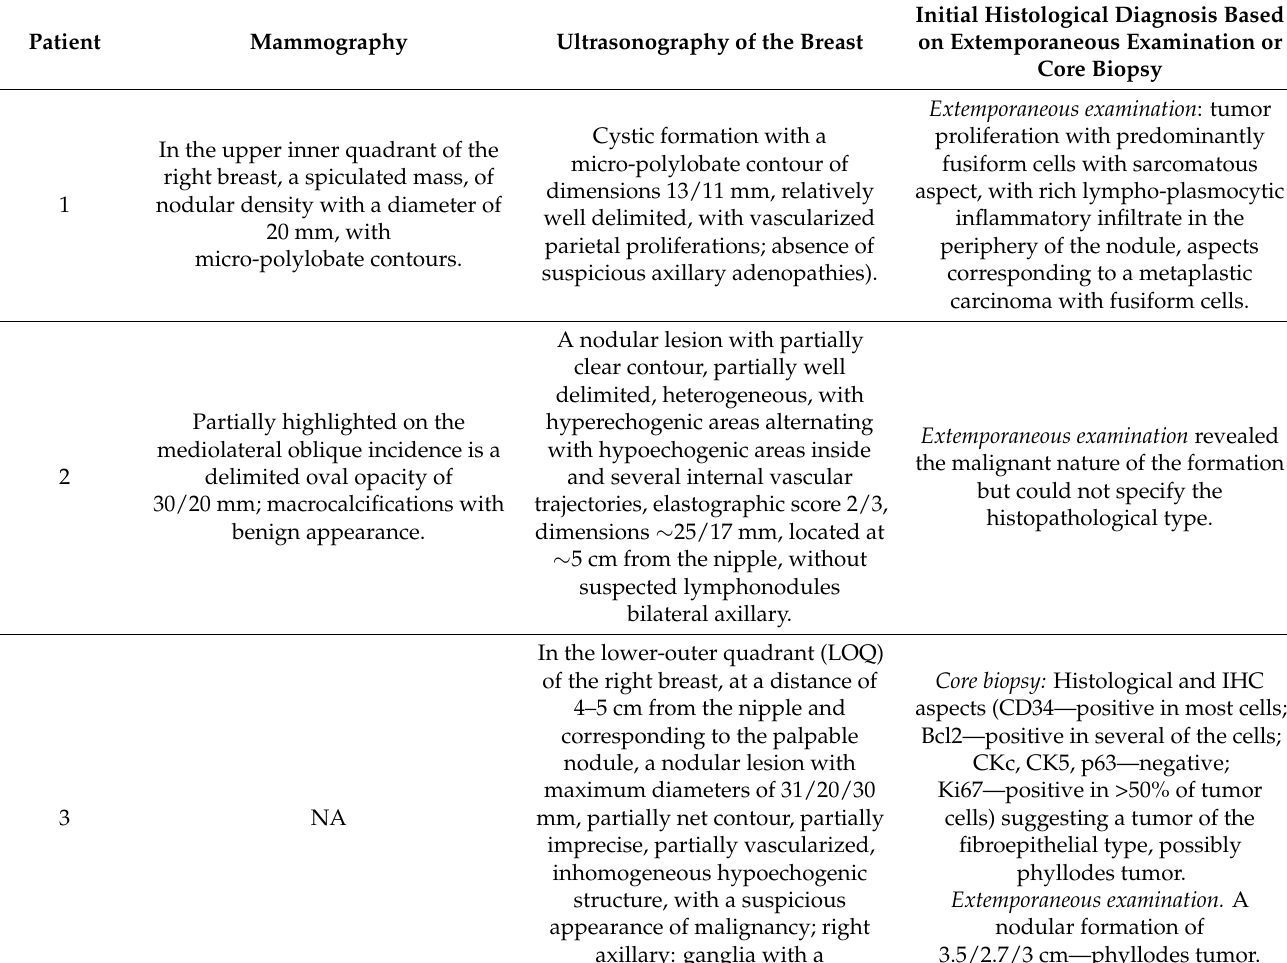
Table 2. Conventional imaging features and pre- and/or intraoperative pathological characteristics in patients with